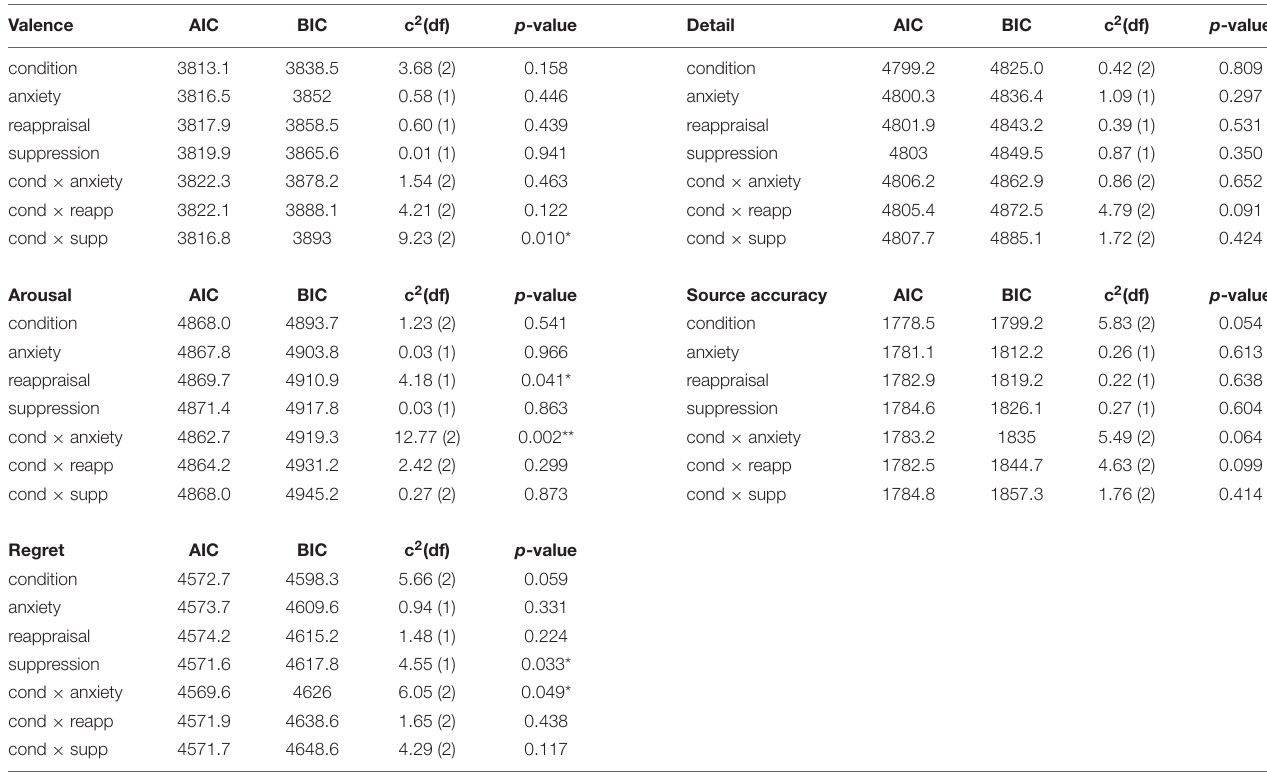
TABLE 2 | Statistical outputs for each of the linear mixed effects model builds.